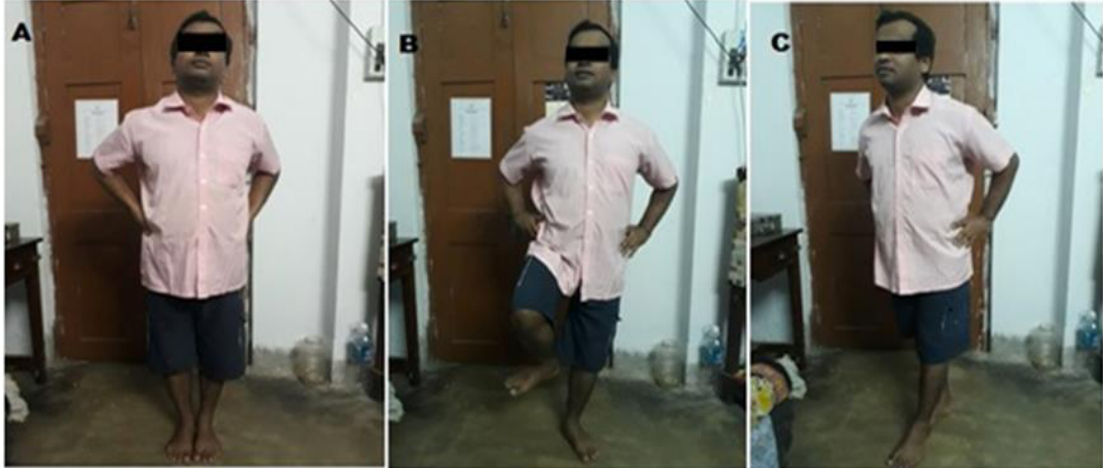
Figure 1. A. Double Leg stance; B. Single Leg stance; C. Tandem stance on the firm (hard) surface in both Non-Dominant Leg (NDL) and Dominant Leg (DL).